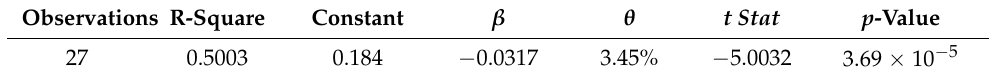
Table 3. Ordinary least squares (OLS) regression of DESI overall index.